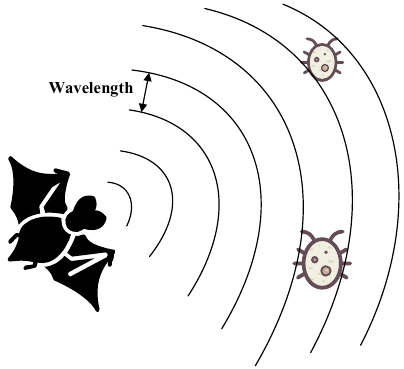
Figure 1. Schematic diagram of the bat’s preying behavior.